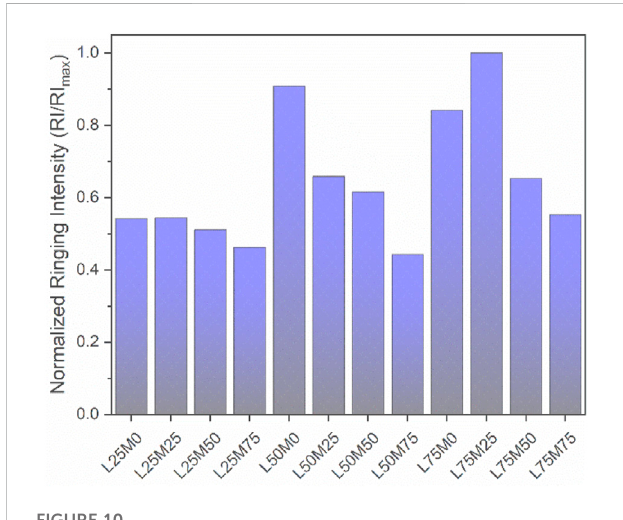
FIGURE 10 Normalised ringing intensity as a function of load and MES.